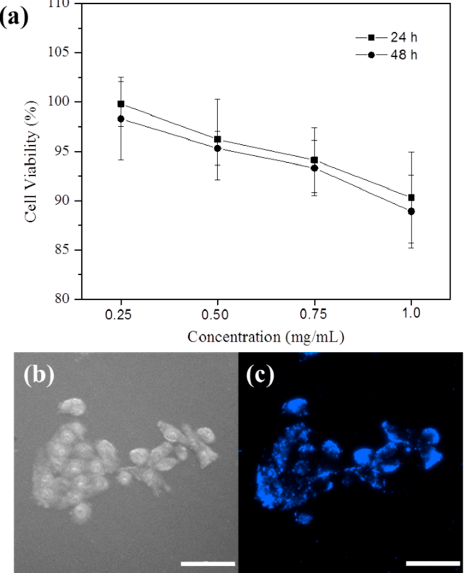
Figure 8. ( a ) Viability of KB cells after incubation with the PEGylated fluorescent NPs of different concentrations for 24 and 48 h; ( b ) bright-field and ( c ) fluorescent images of KB cells after incubation with 0.2 mg/mL of the PEGylated fluorescent NPs for 4 h. The scale bar is 100 μ m.